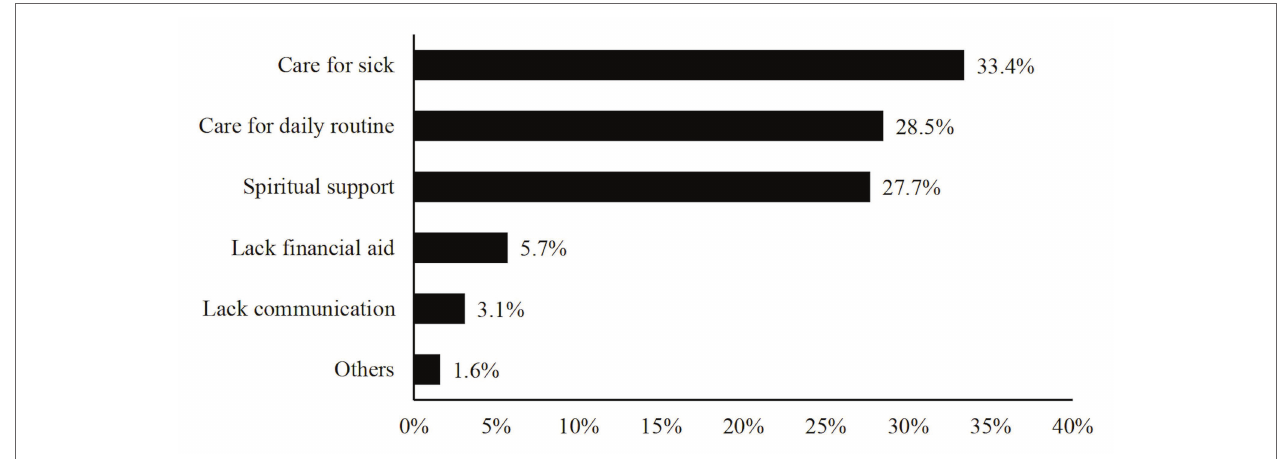
FIGURE 1 | Most challenging aspect in parents’ later